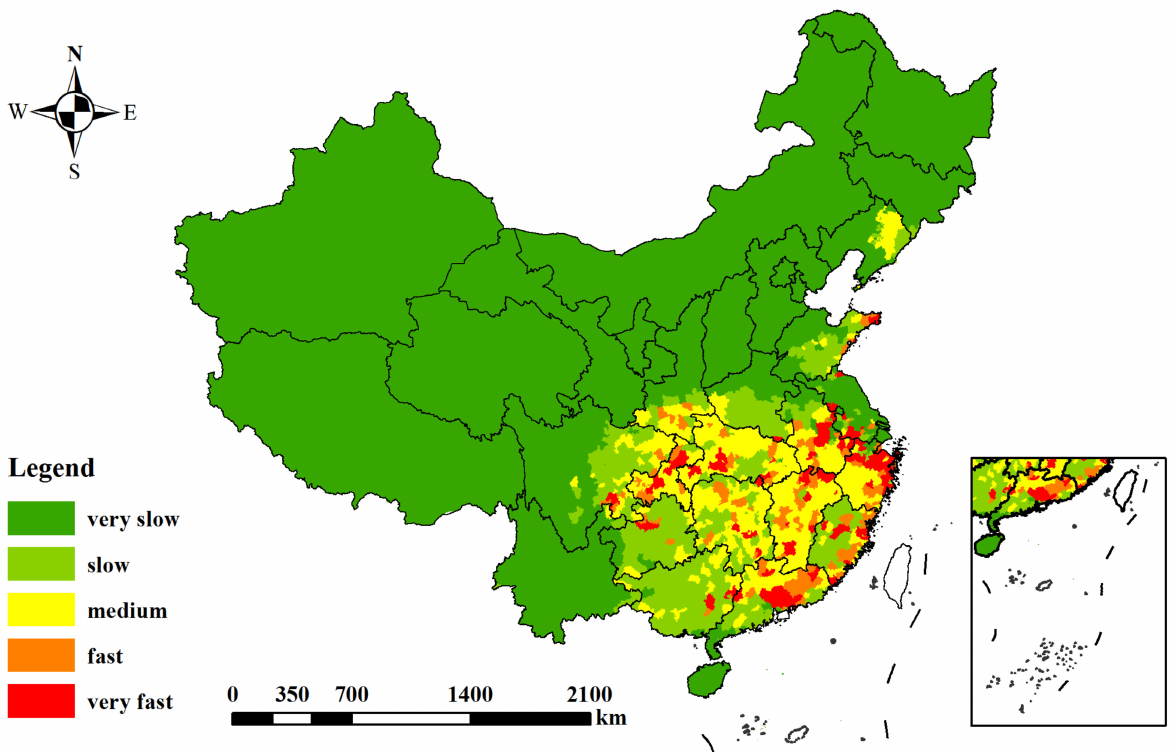
Figure 7. Changes in PWD risk measured by the slope of the Prisk regression model in